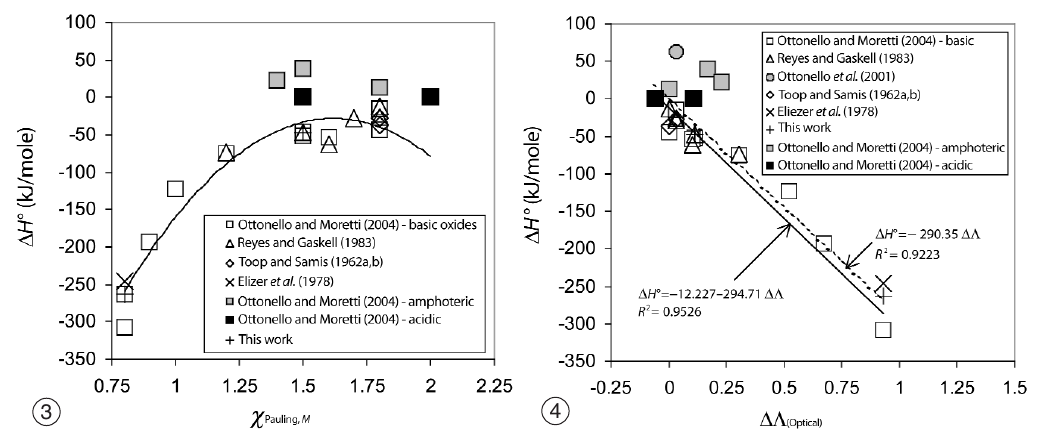
Fig. 3. Reaction enthalpy of equilibrium 2 plotted against Pauling’s electronegativity of MO metal cation. Fig. 4. Reaction enthalpy of equilibrium 2 plotted against difference in optical basicity of MO and SiO 2 . Adopt- ed basicity values are those of column 6 in table A1 of Ottonello et al . (2001). Selection of other basicity values within uncertainty ranges (columns 1 to 6 in same table) do not greatly alter observed relations.